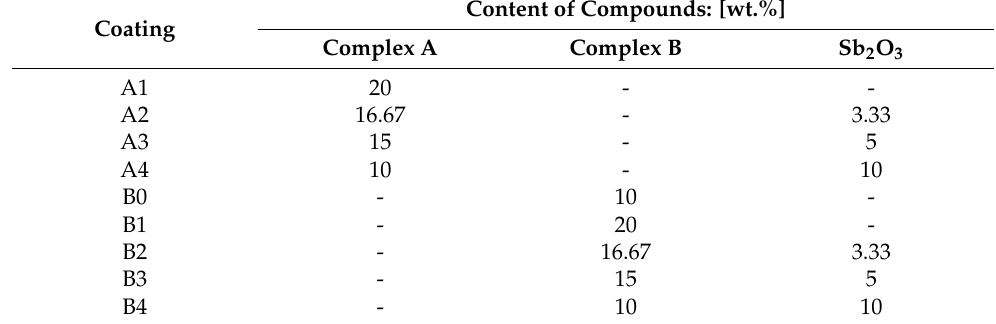
Table 1. Composition of